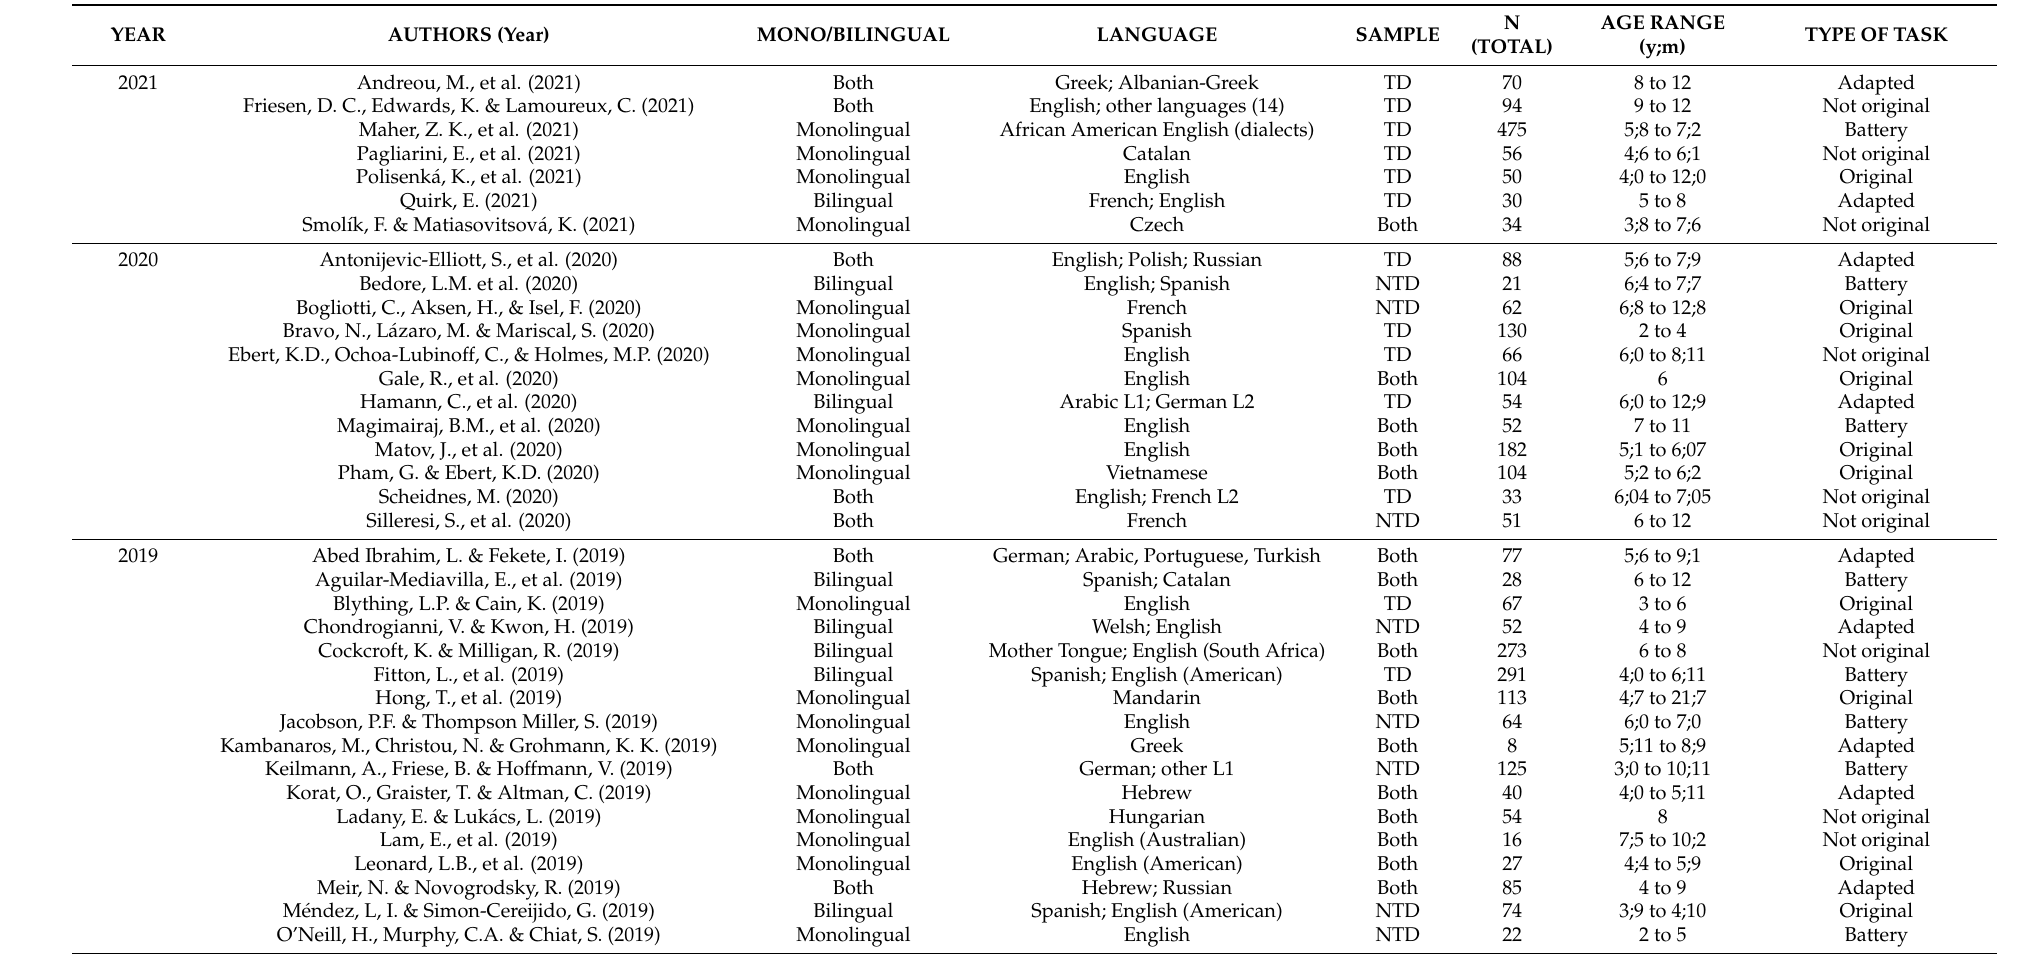
Table A1. Studies included in the scoping review